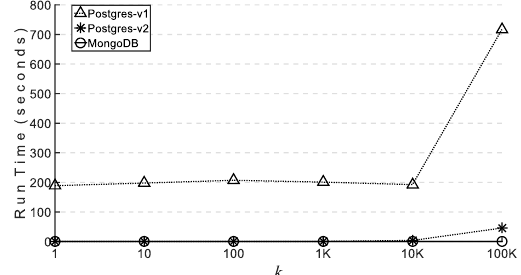
Figure 3 Execution analysis for whole year of 2015 As expected Postgres-v2 is faster than Postgres-v1, since it first finds the query point and then calculates the distance to the remaining points. Execution times of Postgres-v1 and Postgres- v2 remain steady until k reaches 100K. At that point, the average execution times increase substantially and reach 715 and 45 seconds in Postgres-v1 and Postgres-v2 respectively. This complex behaviour is probably related to the default parameter settings of Postgres (e.g. effective_cache_size, work_mem, max_fsm_pages etc.) as well as the index and the operating system (Cao et al., 2008). MongoDB, just like Postgres-v2, first determines the query point and then determines the k NN of that point. Surprisingly, MongoDB detected the k NN of a query point immediately and regardless of the value of k unlike Postgres-v2. The second part of the analysis is to determine the match percentage of the detected neighbours of different approaches.